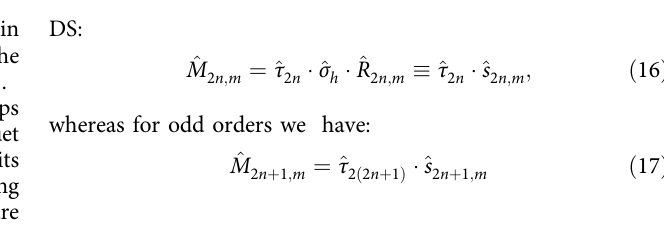
Fig. 4 Example time-periodic (2 + 1)D fi elds characterized by groups with two generators. a A group with the generators ^ C 2 and ^ D x for the example fi eld E ( t ) ^ D = sin( ω t ) ^ x + cos(3 ω t ) ^ y , ( b ) a group with the generators ^ Z fi eld E ( t ) = sin( ω t ) ^ x + sin(2 ω t ) ^ y , and ( c ) a group with the generators ^ C y and x for the example and ^ D x for the example fi eld E ( t ) = (cos( ω t ) + cos(2 ω t )) ^ x + (sin( ω t ) − sin(2 ω t )) ^ y . The fi elds are represented on Lissajou plots. The spatial parts of the operators are indicated by dashed lines and arrows, colored arrows in the plots indicate the direction of